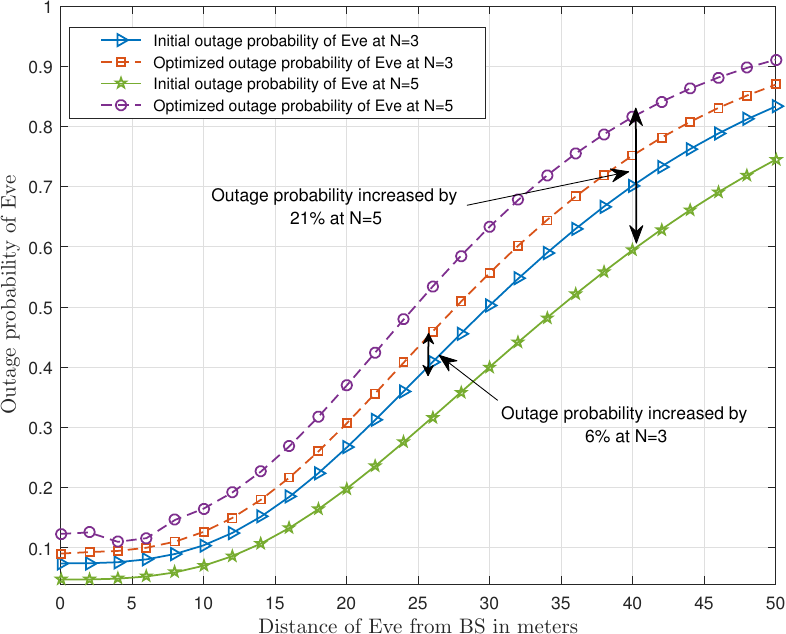
Figure 6. Comparison of outage probability of Eve with the distance of Eve from the BS. Figure 7 indicates the behaviour of outage probability of user-B and Eve under